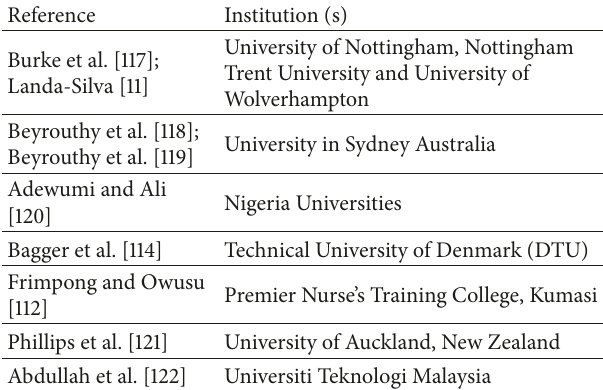
Table 17: Summary of real-world SAP from different institutions.